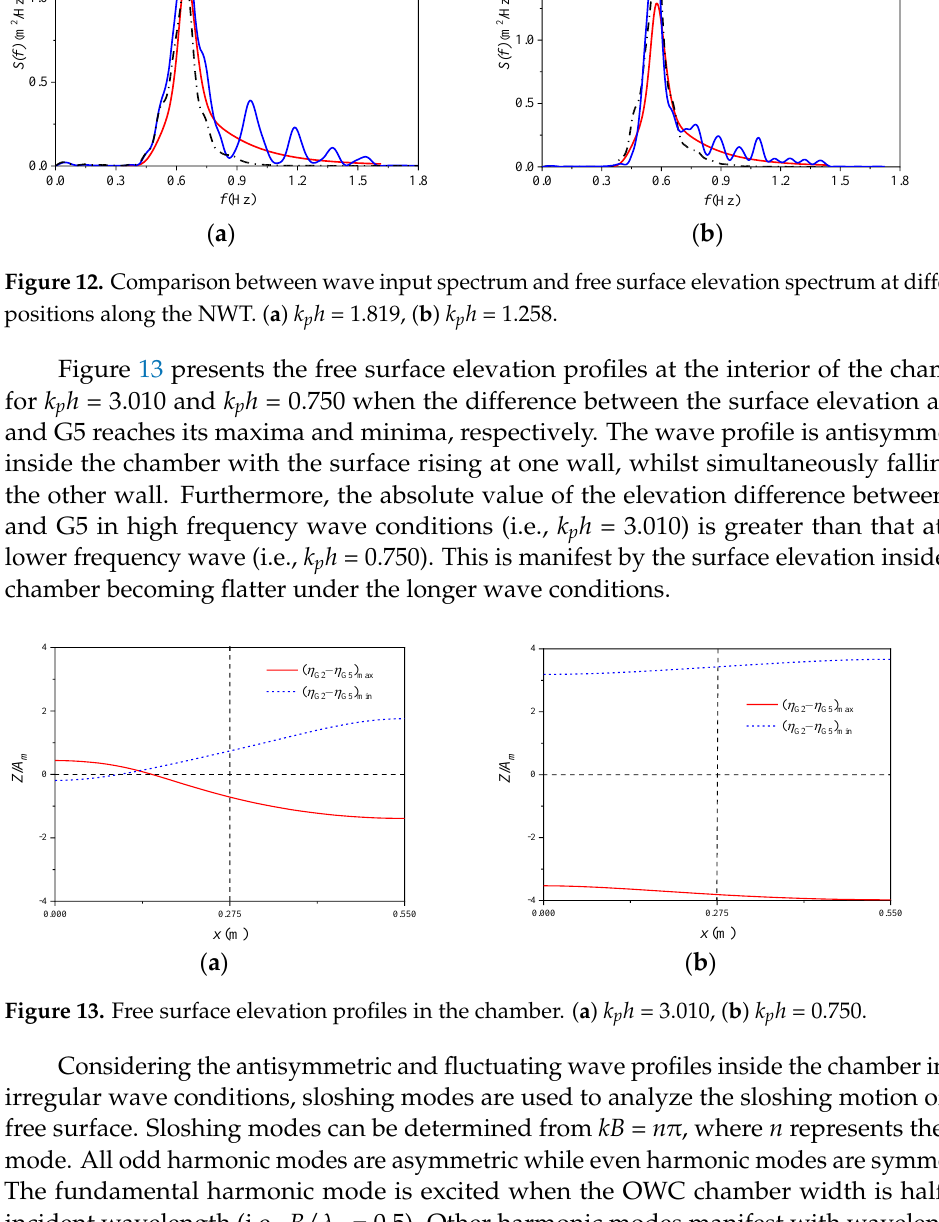
Figure 12. Comparison between wave input spectrum and free surface elevation spectrum at dif- ferent positions along the NWT. ( a ) k p h = 1.819, ( b ) k p h = 1.258.